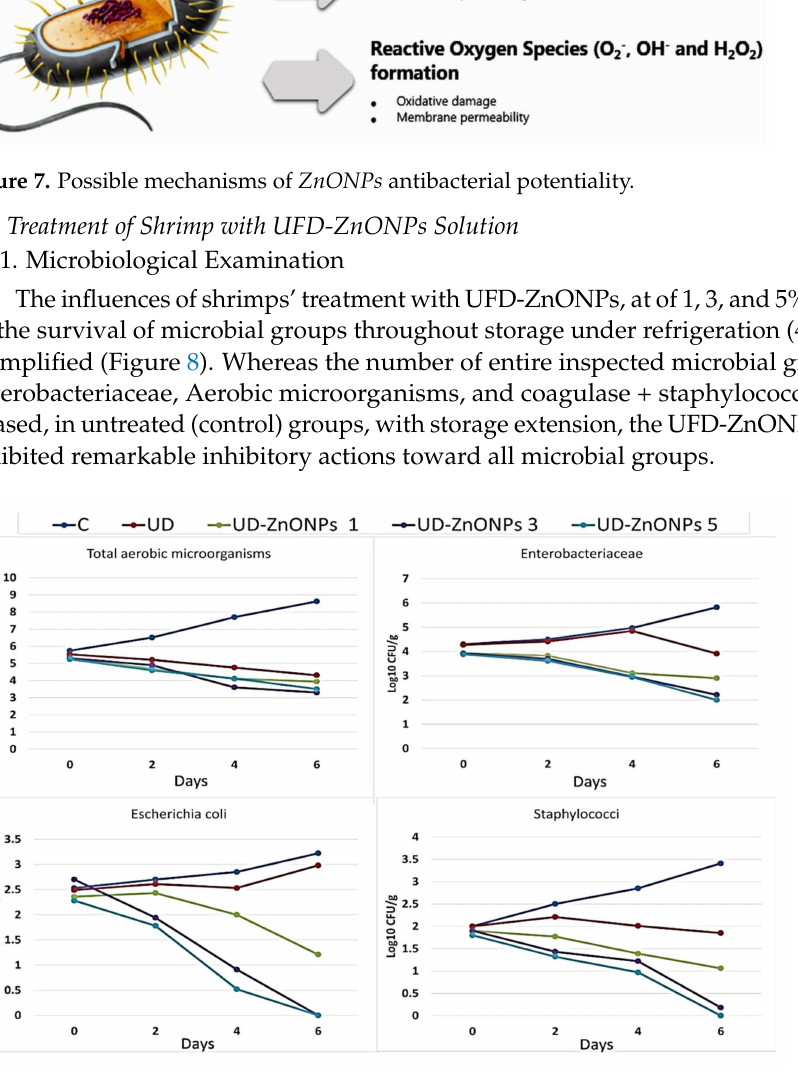
Figure 8. Influence of shrimp treatment with UFD extract and 1, 3 and 5% ( w / v ) from UFD-ZnONPs ( UFD-ZnONPs 1, UFD-ZnONPs 3, and UFD-ZnONPs 5, respectively) on the microbial load during six days of storage (4 ± 1 ◦ C), compared to non- UFD-ZnONPs treated group